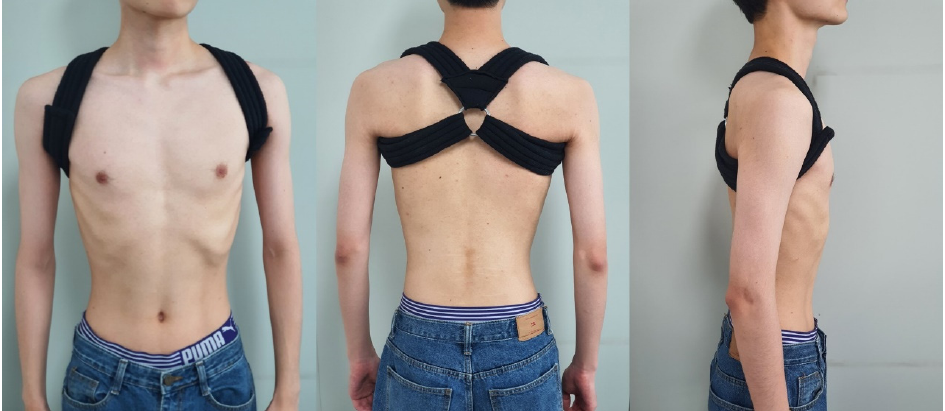
Figure 1. The 8-figure shoulder brace.